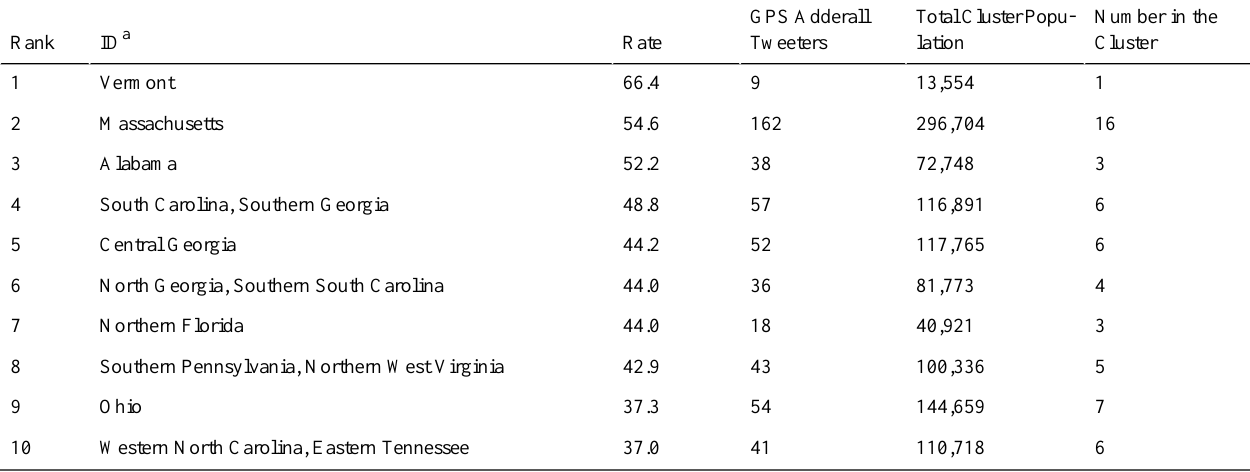
Table 3. Top 10 rates of Adderall tweets for 150-mile college and university clusters in the United States.